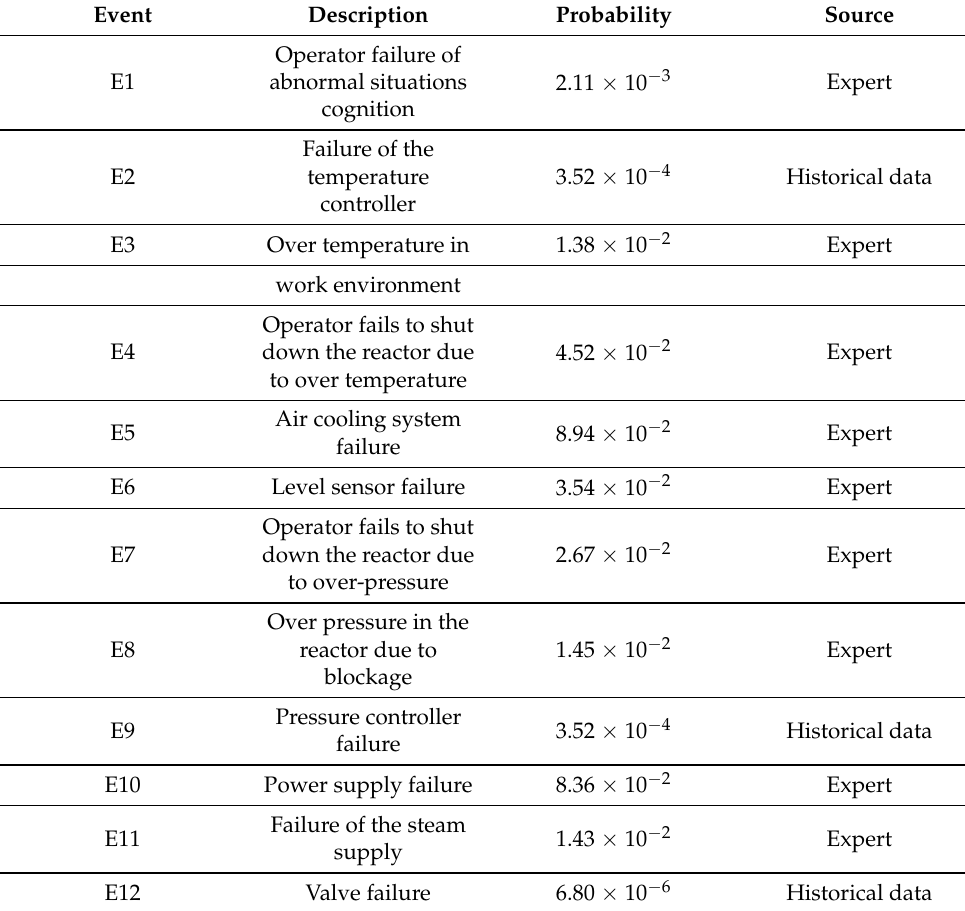
Table 4. Description of the main events and their corresponding failure probabilities.